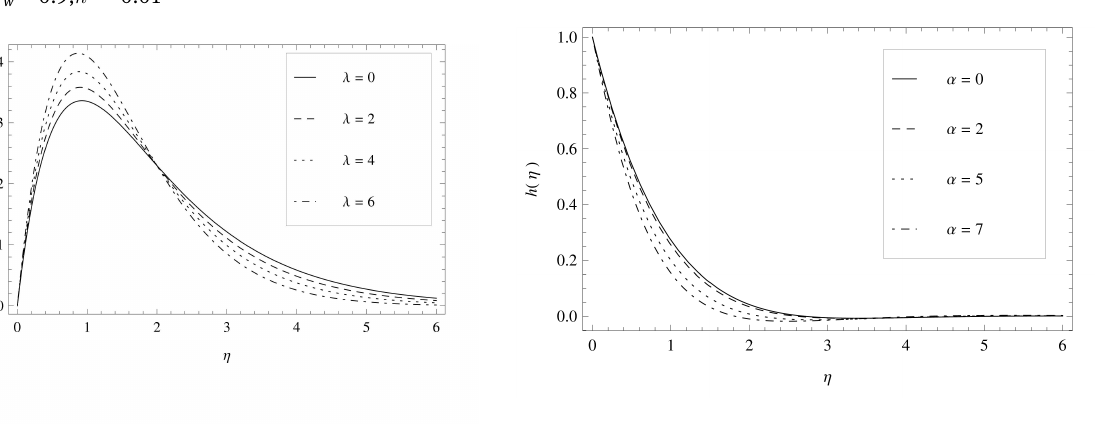
Fig. 16: The influence of a parameter f w on k ( η ) for λ = 0.5, We = 0.3, α = 2, M = 0.5 and (cid:126) = −0.01